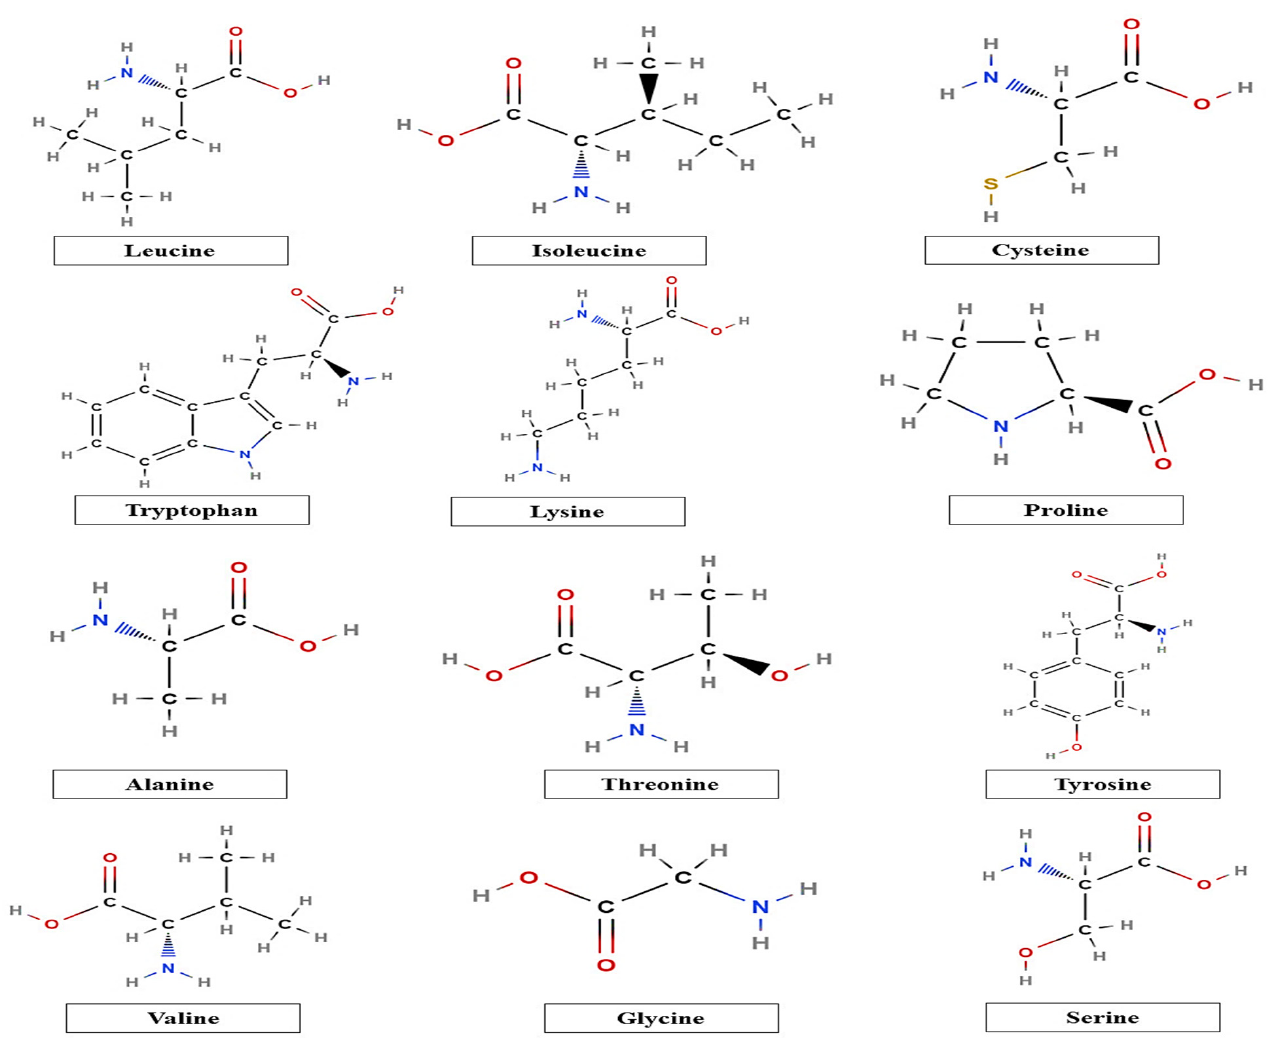
Figure 2. Chemical structures of different amino acids present in taro mucilage.